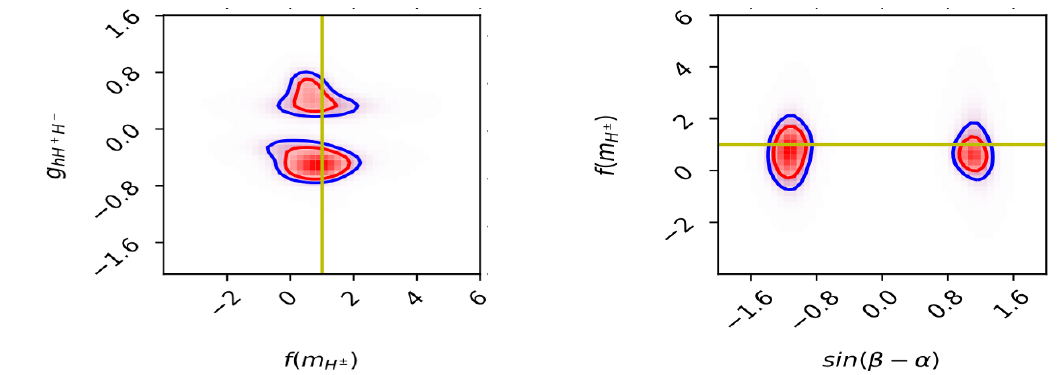
Figure 10 . Allowed regions at 1 (cid:27) (red) and 2 (cid:27) (blue) levels in the parameter space of f ( m g (left) and sin( (cid:12) (cid:0) (cid:11) ) (cid:0) f ( m hH + H (cid:0)